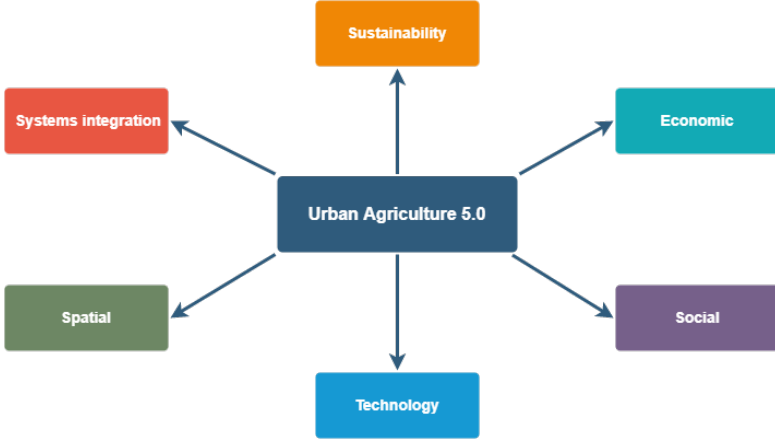
Figure 4. Urban agriculture 5.0 dimensions. source: authors